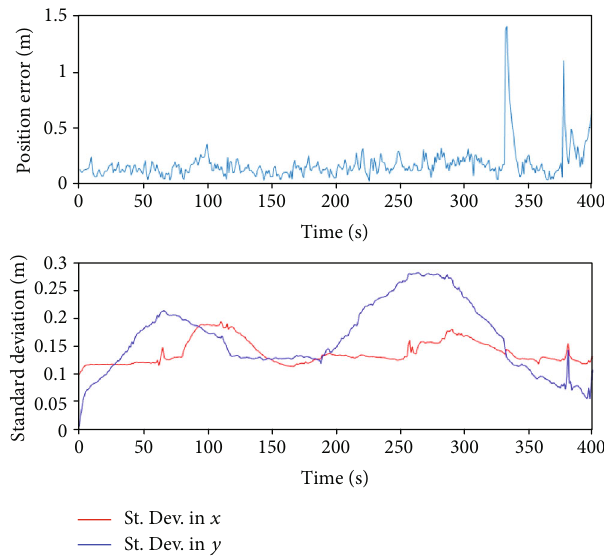
Figure 12: Improved algorithm control results for Experiment 2 environment.